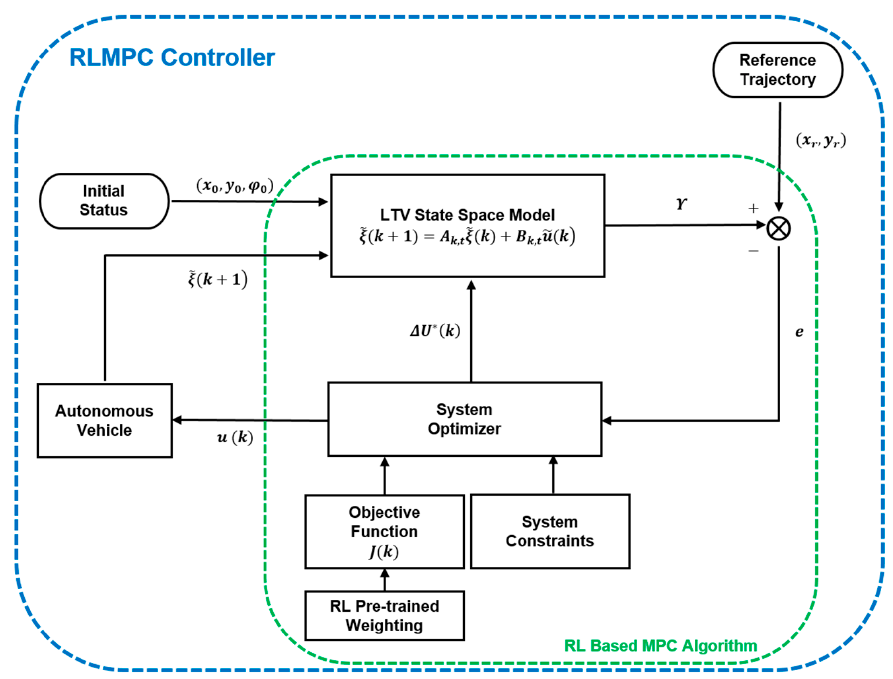
Figure 4. Proposed RL-based MPC (RLMPC) training